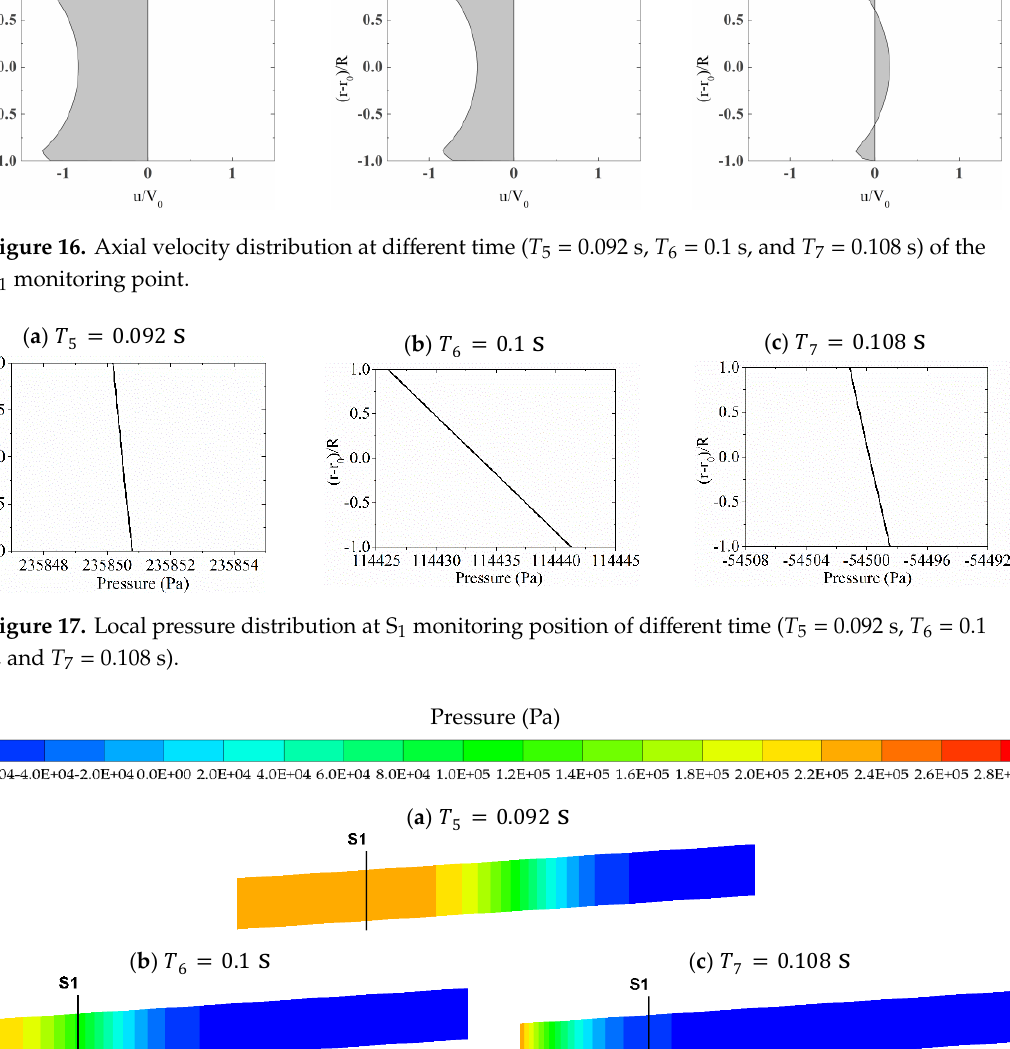
( b ) 𝑇 4 = 0.064 s Figure 14. Local pressure distribution at S1 monitoring position of different time ( 𝑇 3 = 0.058 s and 𝑇 4 = 0.064 s ) . Pressure (Pa) ( a ) 𝑇 3 = 0.058 s ( b ) 𝑇 4 = 0.064 s Figure 15. Pressure field evolution on the axis plane of the pipeline ( 𝑇 3 = 0.058 s and 𝑇 4 = 0.064 s ) . Stage 3: The pressure decrease wave generated at the valve propagates upstream, Figures 16 and 17 are respectively the axial velocity distribution and local pressure distribution at the S 1 monitoring position of different time, and Figure 18 is the pressure field evolution on the axis plane of the pipeline in this stage. At 𝑇 5 = 0.092 s = 𝑇𝑐 + 2.42 × 𝐿/𝑎 , the pressure head at S 1 position is 24.08 m, and the velocity distribution in Figure 16a exhibits that the velocity at the wall region firstly begins to change (with cross-sectional average velocity of 𝑈 ̅ = −0.233 m/s ), and the velocity change gradually diffuses to the core region, at 𝑇 6 = 0.1 s = 𝑇𝑐 + 2.7 × 𝐿/𝑎 , 𝑈 ̅ = −0.14 m/s . After the pressure wave passes (Figure 18c, 𝑇 7 = 0.108 s = 𝑇𝑐 + 2.99 × 𝐿/𝑎 ), the pressure head at S 1 monitoring position decreases to the minimum, −5.57 m, and the axial average velocity is 0 m/s, the velocity distribution in Figure 16c is similar to that in Figure 10c. In the process, the velocity distribution of the core region remains the same to the initial shape, but the velocity peak clearly spreads to the core region. The